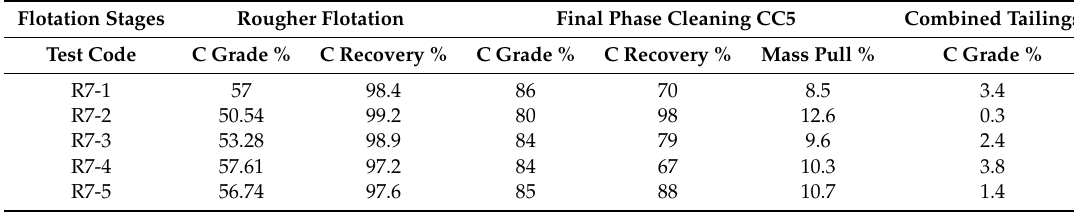
Table 4. Results of flotation tests after fifth cleaning stage